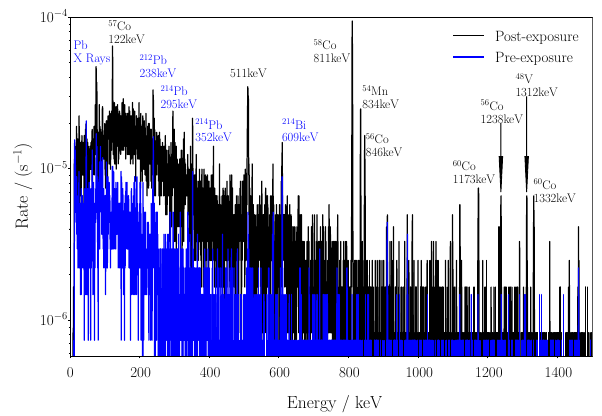
Fig. 2 Measured spectra of OFHC copper samples pre- (blue) and post-exposure (black) with a bin-size of 0.36 keV. Gamma-ray peaks inducedbycosmogenicactivationsandprimordalradionuclidesarealso indicated